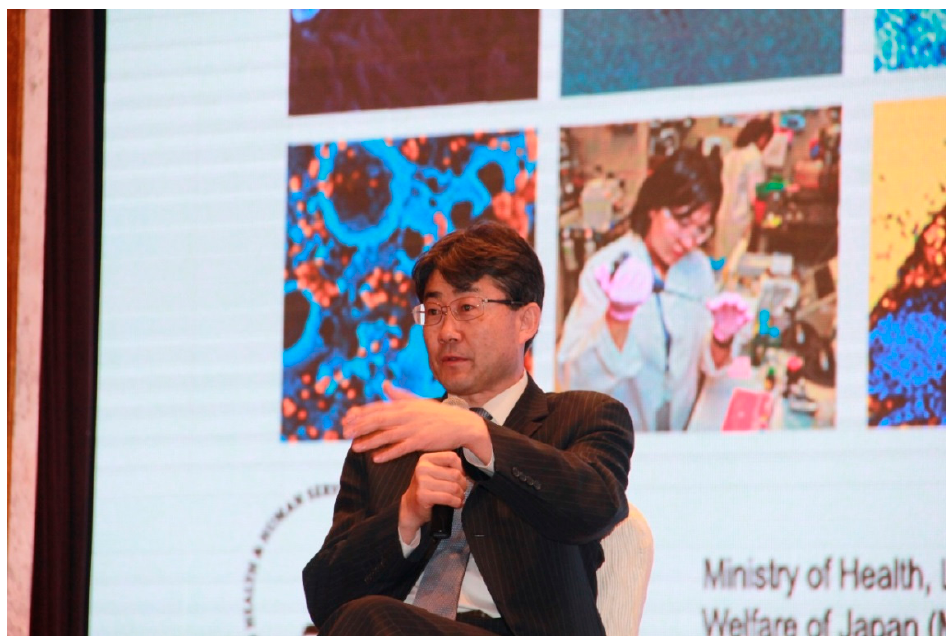
Figure 3. Local host Dr. George F. Gao (Photo used with permission from Dr. Gao).